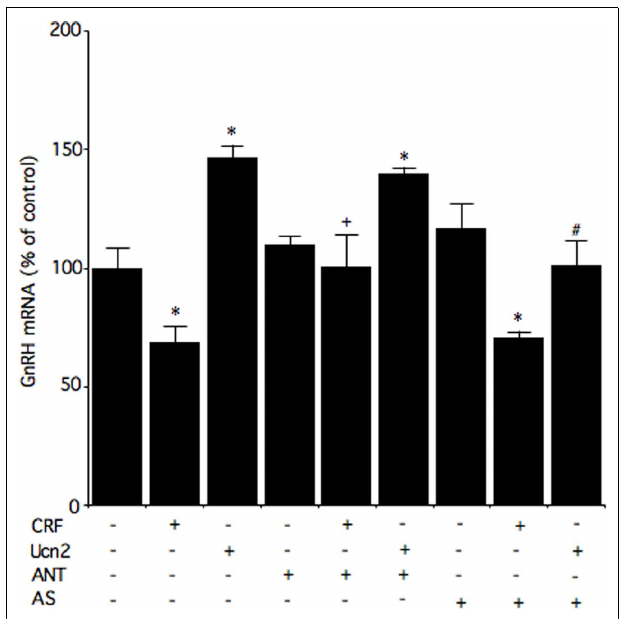
FIGURE 2 | Effects of a CRF receptor antagonist on the effects of CRF and Ucn2 on GnRH mRNA levels in N39 cells. Cells were pre-incubated with medium containing 1 μ M antalarmin (ANT), antisauvagine-30 (AS), or vehicle for 30 min, and then incubated for 6 h with medium containing 100 nM CRF, 100 nM Ucn2, or vehicle. Reproduction from Kageyama etal. (2012) with permission of the publisher. Copyright 2012,